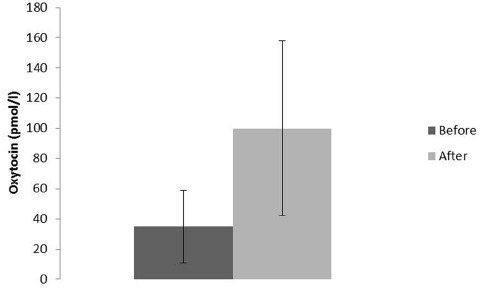
Oxytocin plasma levels in male rats (n = 8) before and after 10 min of stroking (means ± SD). Data from Stock and Uvnäs-Moberg (1988).